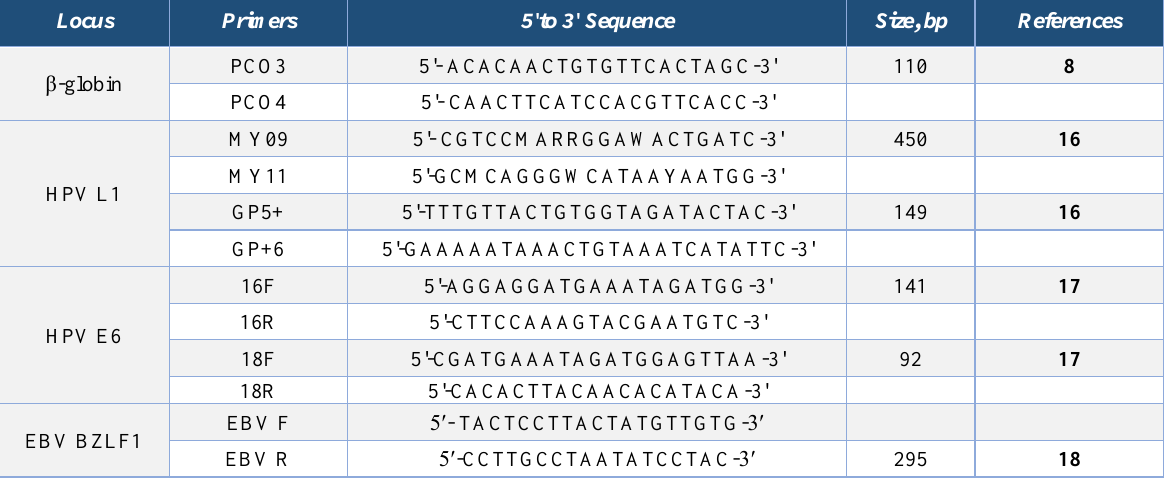
Table 1. The Sequences and other Characteristics of Primers Used in this Study